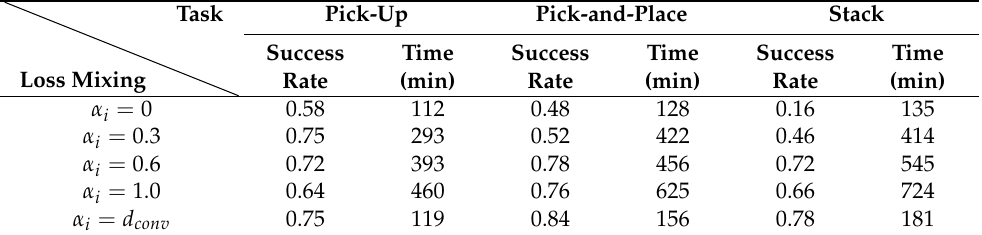
Table 2. Performance comparison among the methods using different loss mixing weights. Task Pick-Up Pick-and-Place Stack Success Time Success Time Success Time Loss Mixing Rate (min) Rate (min) Rate (min) α i = 0 0.58 α i = 0.3